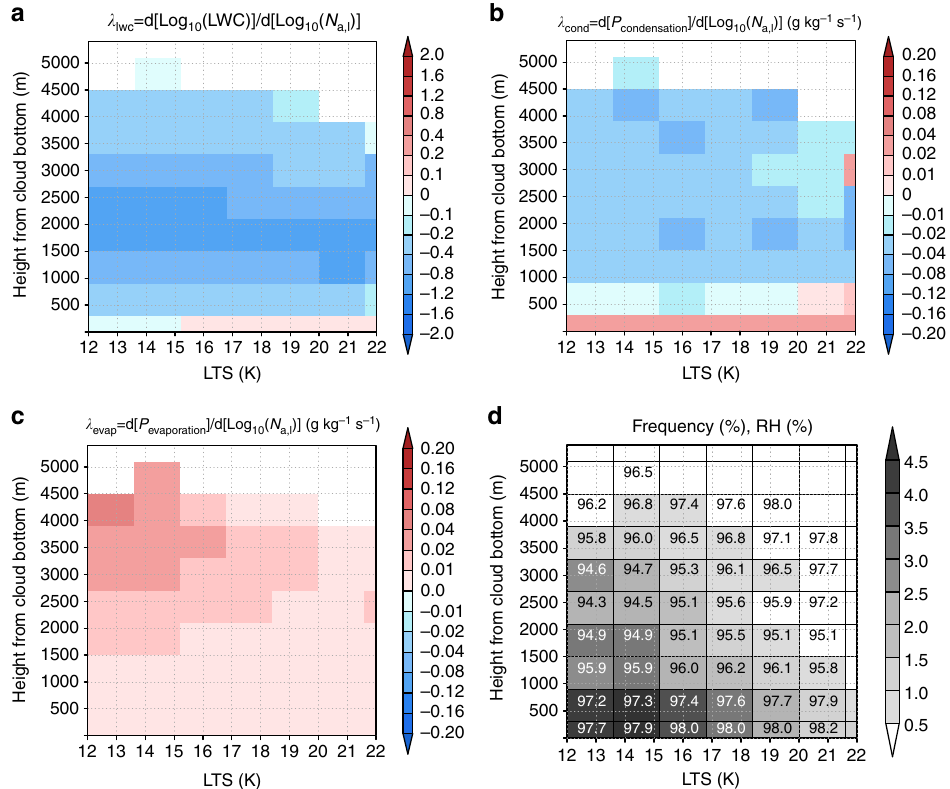
Fig. 2 The vertical distribution of variables to explain the reasons for the negative value of λ simulated by the global cloud system resolving model. Distribution of the a λ lwc , b response of the condensation tendency ( P condensation ) to aerosol perturbations ( λ cond ), c response of the evaporation tendency ( P evaporation ) to aerosol perturbations ( λ evap ), and d frequency and relative humidity (RH) over the lower tropospheric stability (LTS)-height from the cloud bottom plane simulated by the GCRM. The number in each grid of d indicates the RH (%). Results over the ocean between 60 o S to 60 o N were used for creating these fi gures. The cloud bottom was determined as the lowest layer of the grid where the average liquid water content (LWC) was larger than 10 − 5 kg kg −